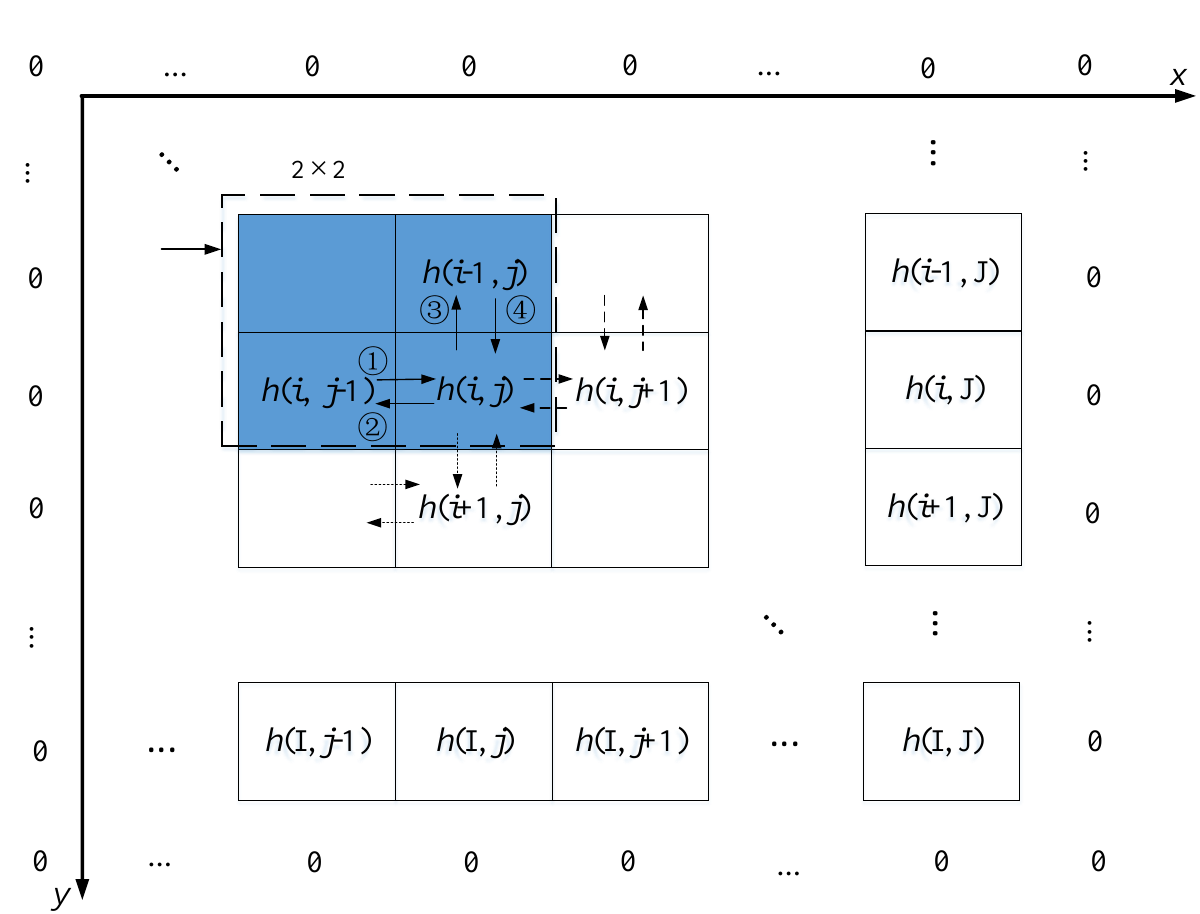
Figure 4. The iterative process of 2D DSR on the k -th band of the HSI. A 2 × 2 window is used to slide the sampling. The dashed lines of different types represent relevant pixels involved in updating the enhancement value of a pixel through Equation (11). The (cid:172) ,..., (cid:175) correspond to the relationship between the pixels in the first to fourth sub-formulas in Equation (12). I × J represents the size of the data in each band of the